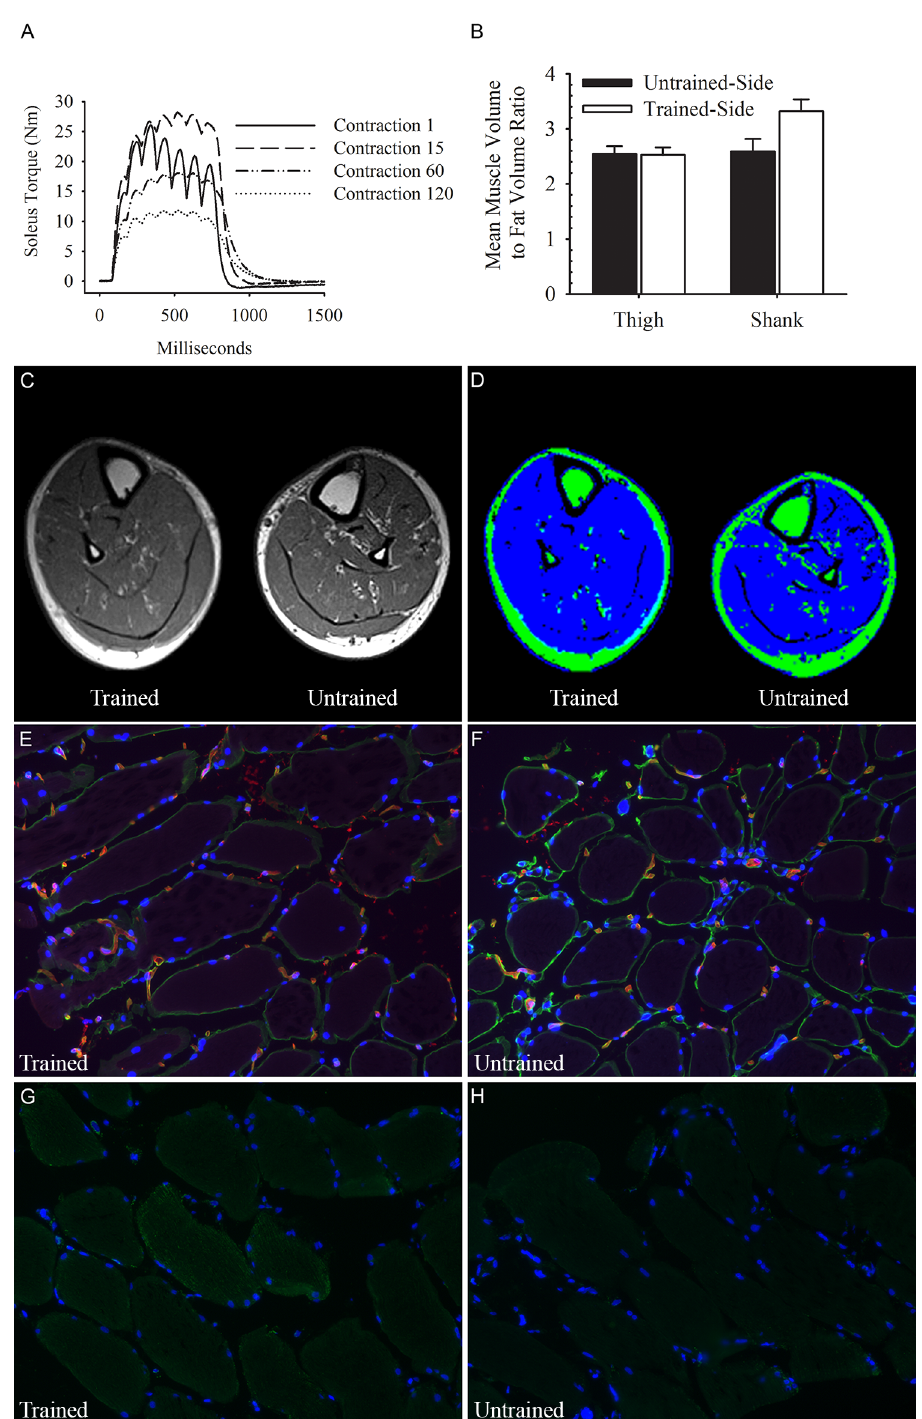
Fig. 1. A representative example of the phenotype for a trained and untrained human paralyzed muscle. (A) A representative example of the torque produced during the stimulation of a chronically paralyzed human soleus muscle, contractions 1, 15, 60, and 120 during the first bout of electrical stimulation are illustrated. (B) The ratio of muscle to adipose tissue from several MR images slices of the proximal shank and distal thigh after . 7 years of unilateral soleus electrical stimulation training in subject 1. A representative